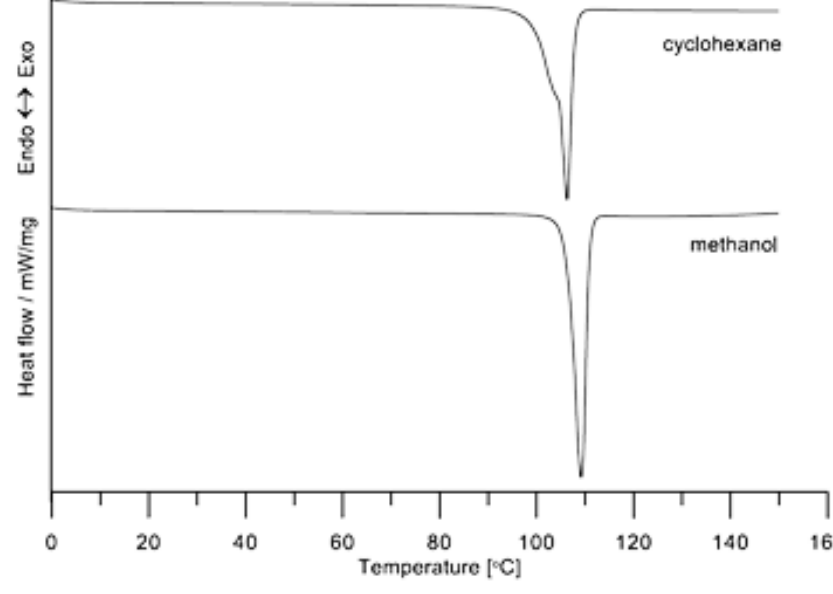
Figure 2. DSC thermograms of AGlc.